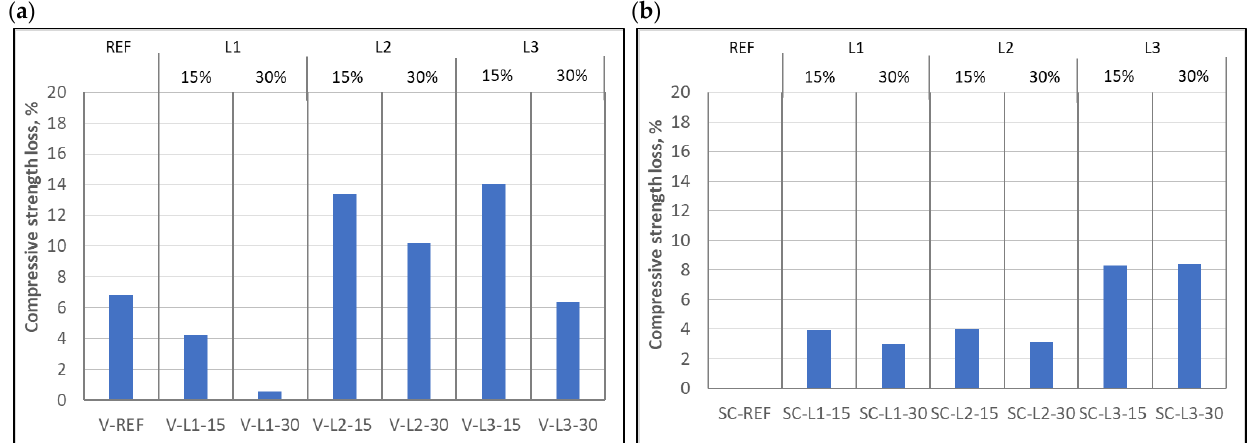
Figure 9. Strength loss for ( a ) vibrated concrete and ( b ) self-compacting concrete, both without air-entraining admixture.